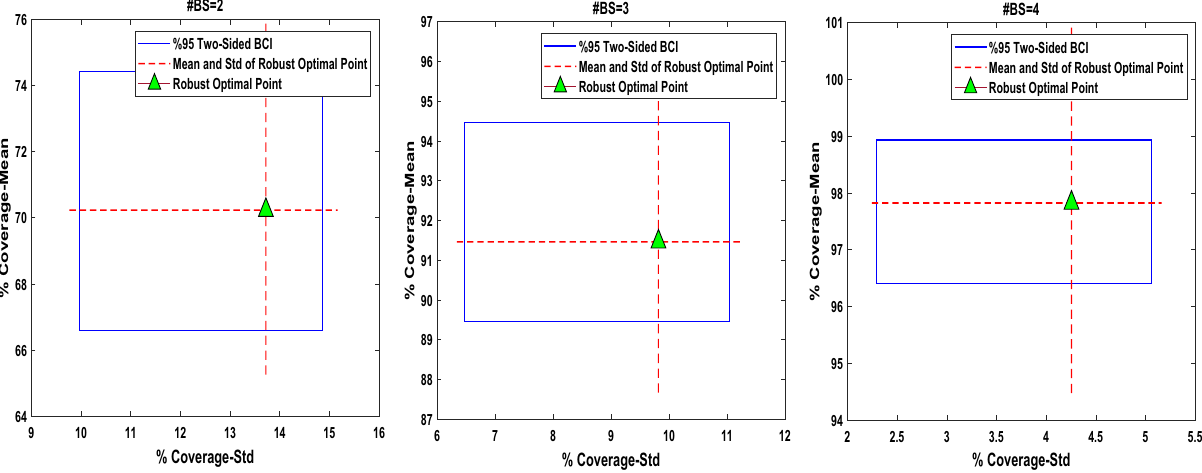
Figure 10. The 95% two-sided confidence region obtained by free-distribution bootstrapping technique for placement problems with two, three, and four